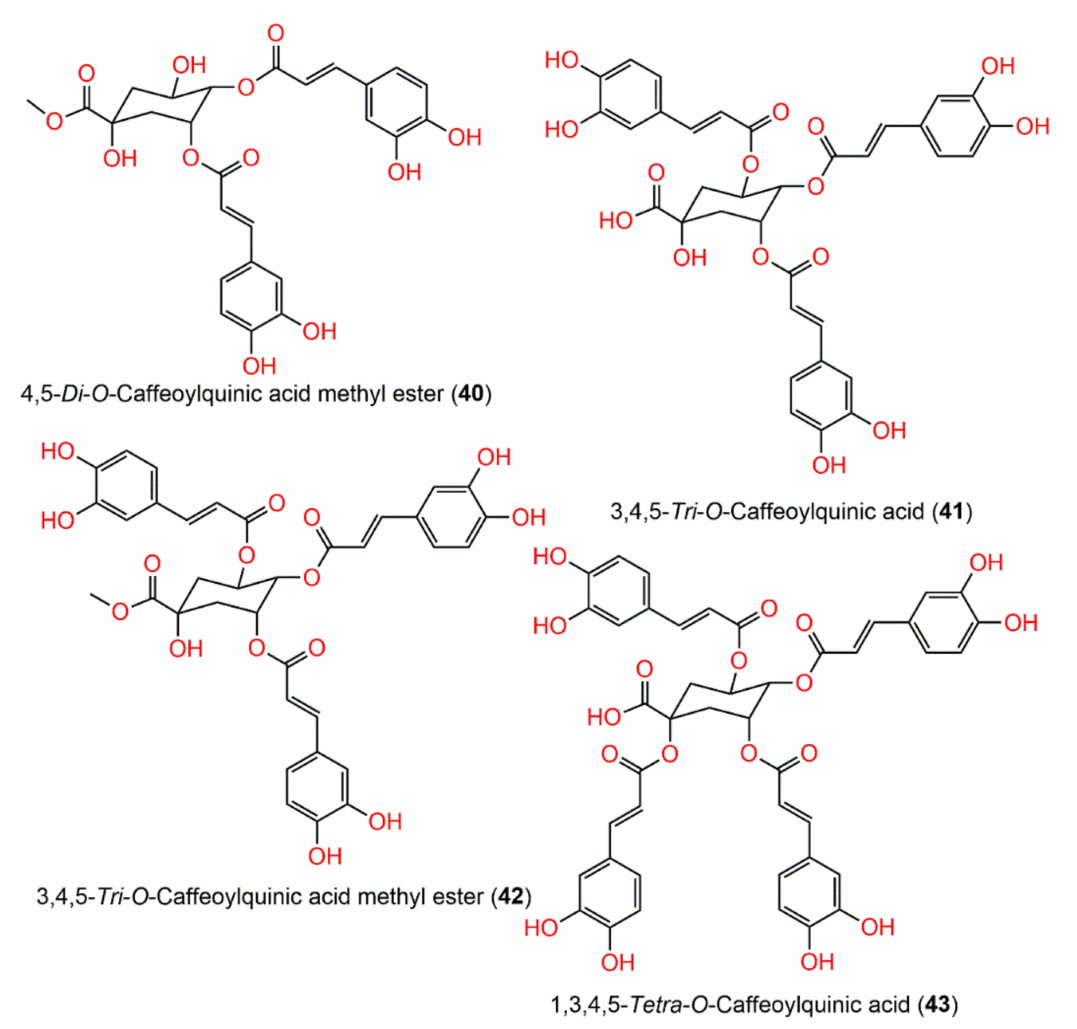
Figure 5. Structures of compounds 40 – 43